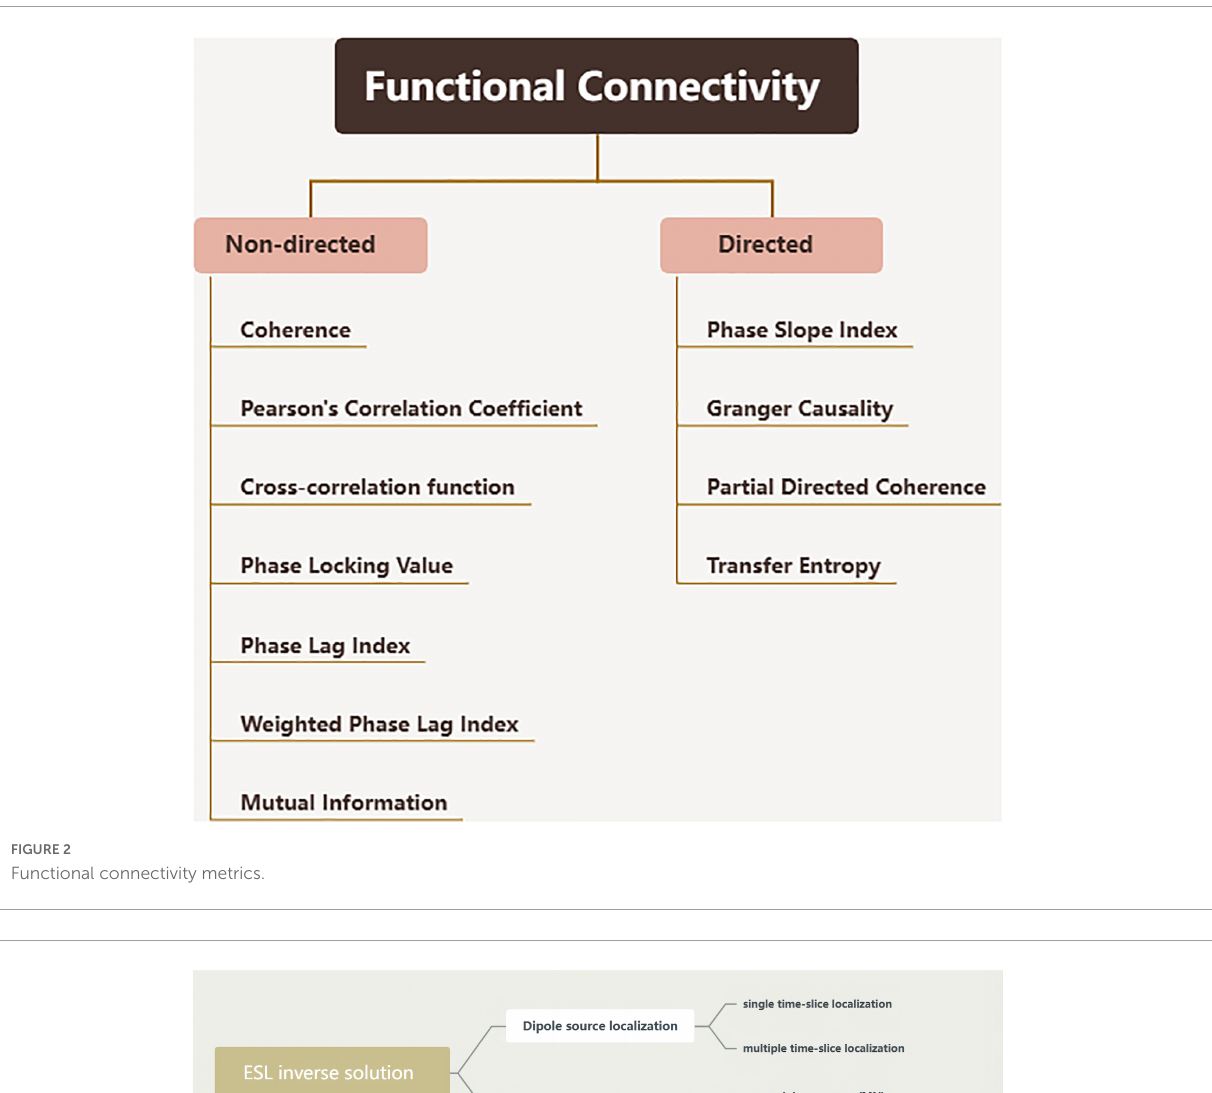
FIGURE3 Inverse solution